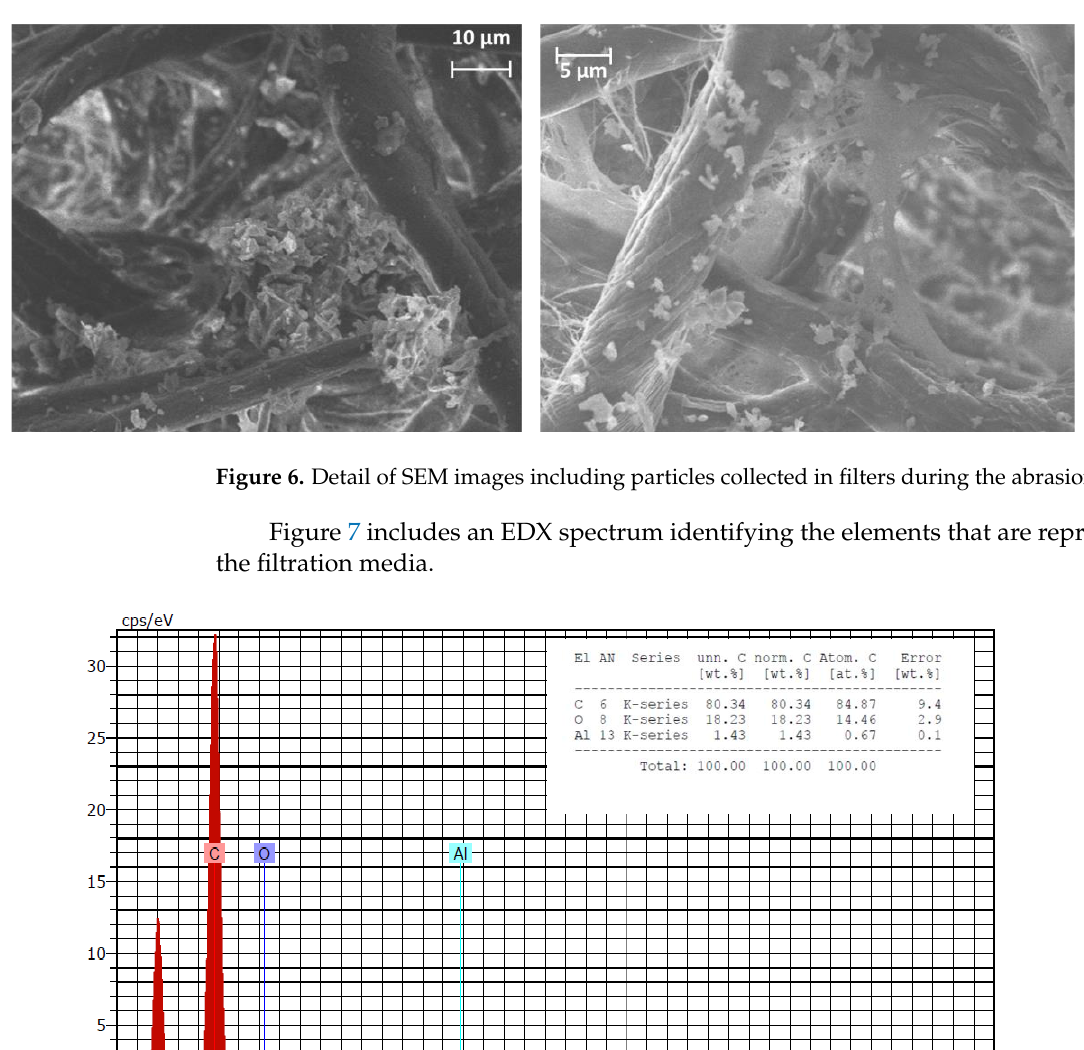
Figure 6. Detail of SEM images including particles collected in filters during the abrasion process.